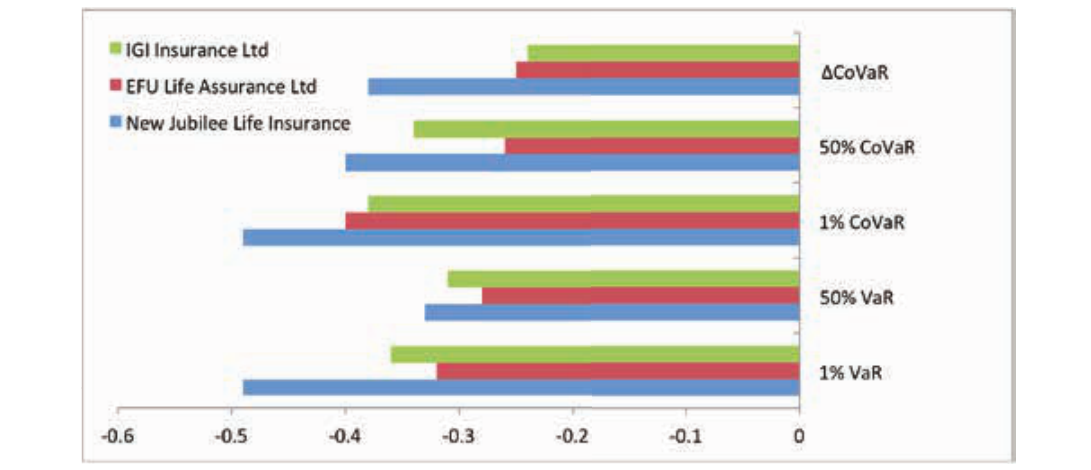
Figure 3: Estimated Risk Measures of Systemically Important Insurance Firms of